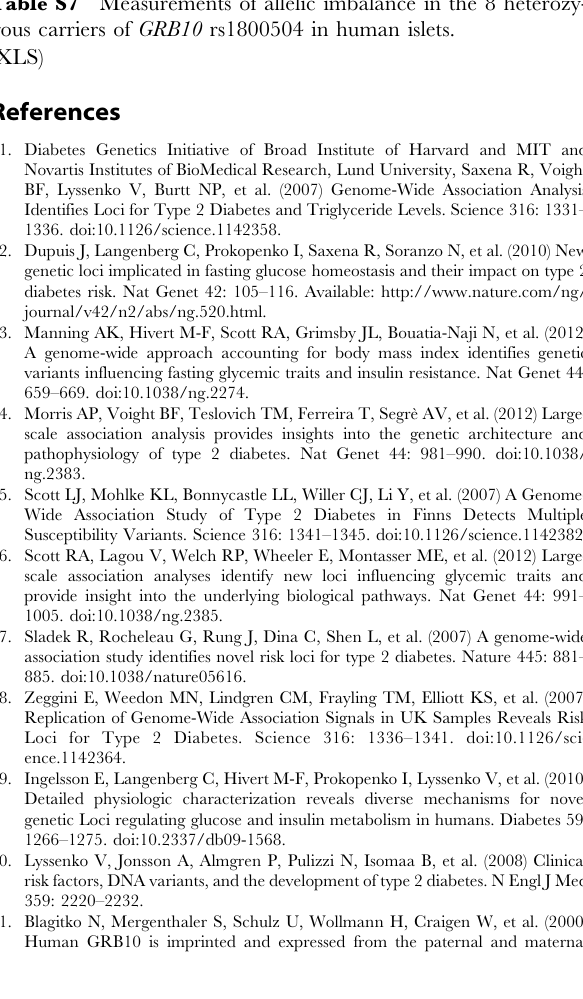
Table S2 (A) Association results of selected SNPs from the discovery GWAS, the CardioMetabochip and the de novo replication genotyping. (B) Meta-analysis of GWAS and Cardio- Metabochip studies: association results with parameters of insulin secretion and insulin action during OGTT for loci previously associated with type 2 diabetes (T2D), 2 hour plasma glucose during OGTT (2hPG), fasting plasma glucose (FGlu), fasting insulin (FIns) and obesity. Table S3 (A) Assessing transmissions of GRB10 rs933360 and rs6943153 alleles in the Trios from Finland and Sweden. (B) Parent-of-origin effect of GRB10 rs933360 on parameters of insulin secretion and insulin action, and glucose levels during OGTT in the non-diabetic offspring from the Trio cohorts. Table S4 Odds ratios for GRB10 rs933360 for risk of T2D in the MPP study. Table S5 (A) Descriptive statistics for the Botnia-PPP cohort. (B) Association between GRB10 rs933360 and glucagon levels in the Botnia-PPP cohort. Table S6 GRB10 SNPs associated with fasting and 2 hr glucose levels in 361 non-diabetic individuals from the DGI GWAS study. Table S7 Measurements of allelic imbalance in the 8 heterozy- gous carriers of GRB10 rs1800504 in human